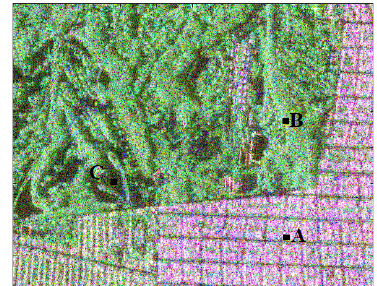
Figure 1. Pauli colour coded image of study area